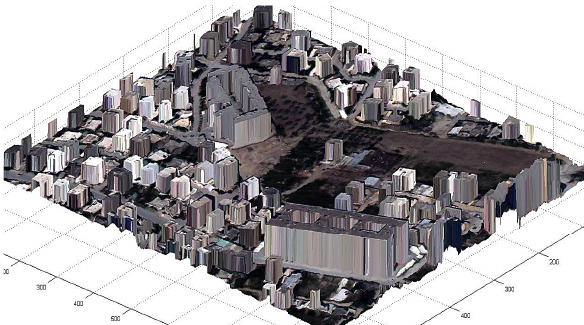
Figure 7: Superimposing of ortho rectified image on 3D prismatic models – zoomed to a smaller region